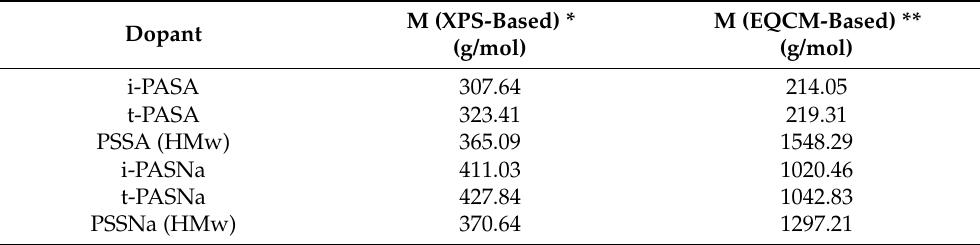
Table 4. Comparison of data obtained by EQCM and XPS for the apparent molar mass corresponding to polymerization. Dopant